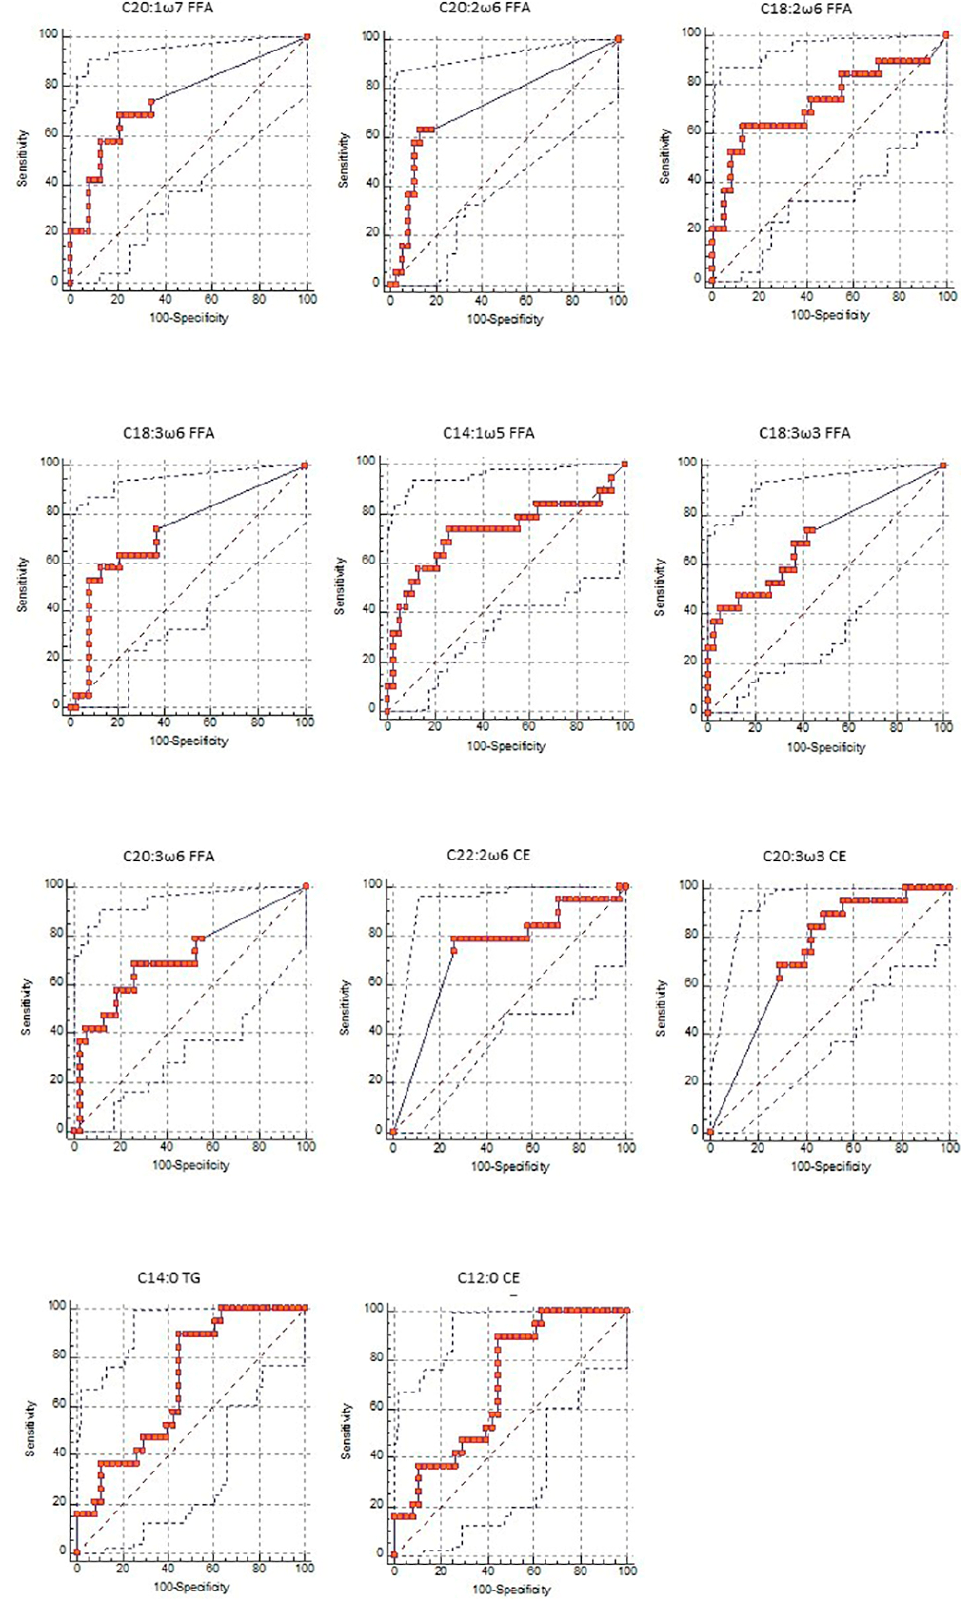
Figure 2. Receiver Operating Characteristic (ROC) curve of predictive fatty acids having Area Under the Curve (AUC) greater than 0.70 and listed with decreasing predictive function obtained from Boruta decisional algorithm.